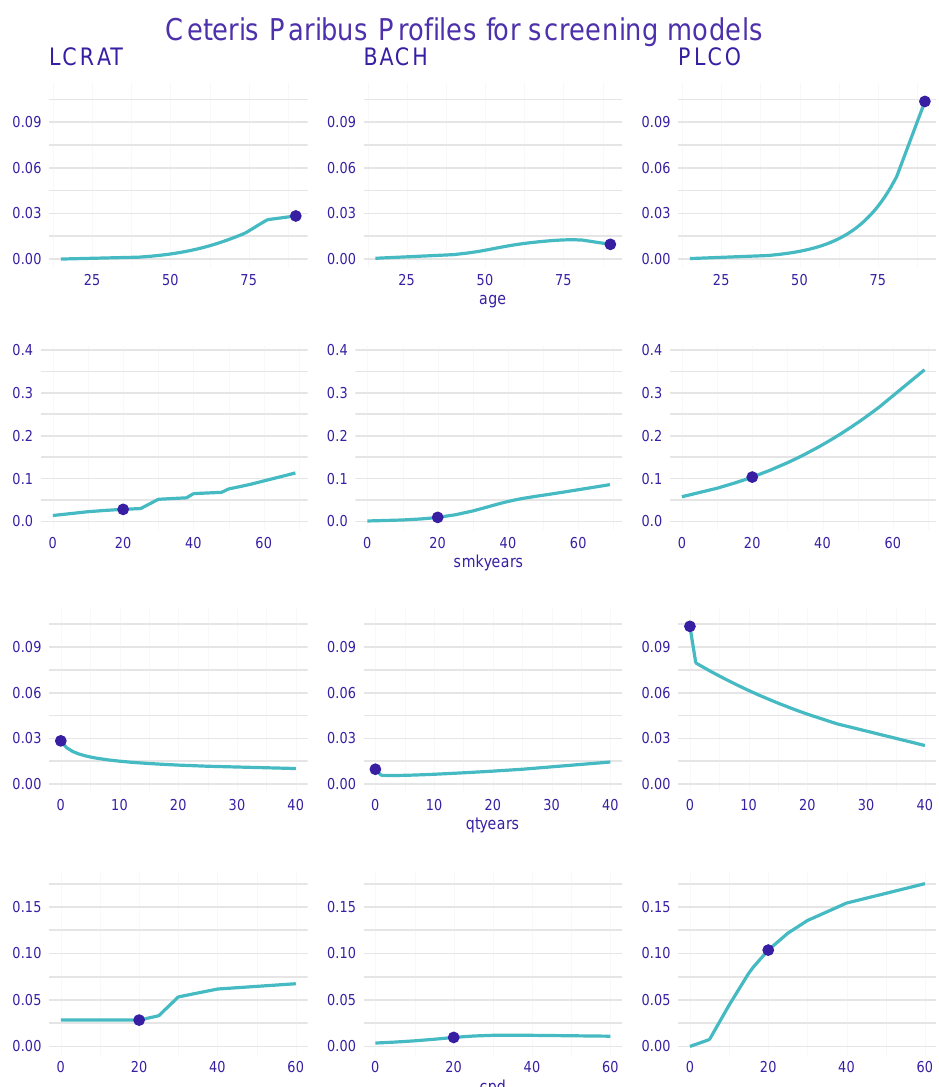
Figure 5. Plots show the dependencies between continuous variables and the prediction for the selected patient. Blue dots indicate the real value of each variable, whereas the green lines correspond to the change of prediction with the change of the variable’s